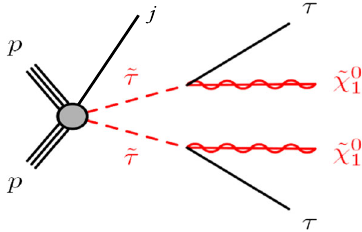
Fig. 14 The schematic diagram of the production process pp → ˜ τ ˜ τ ∗ j + X with the sequent decays ˜ τ → τ ˜ χ 0